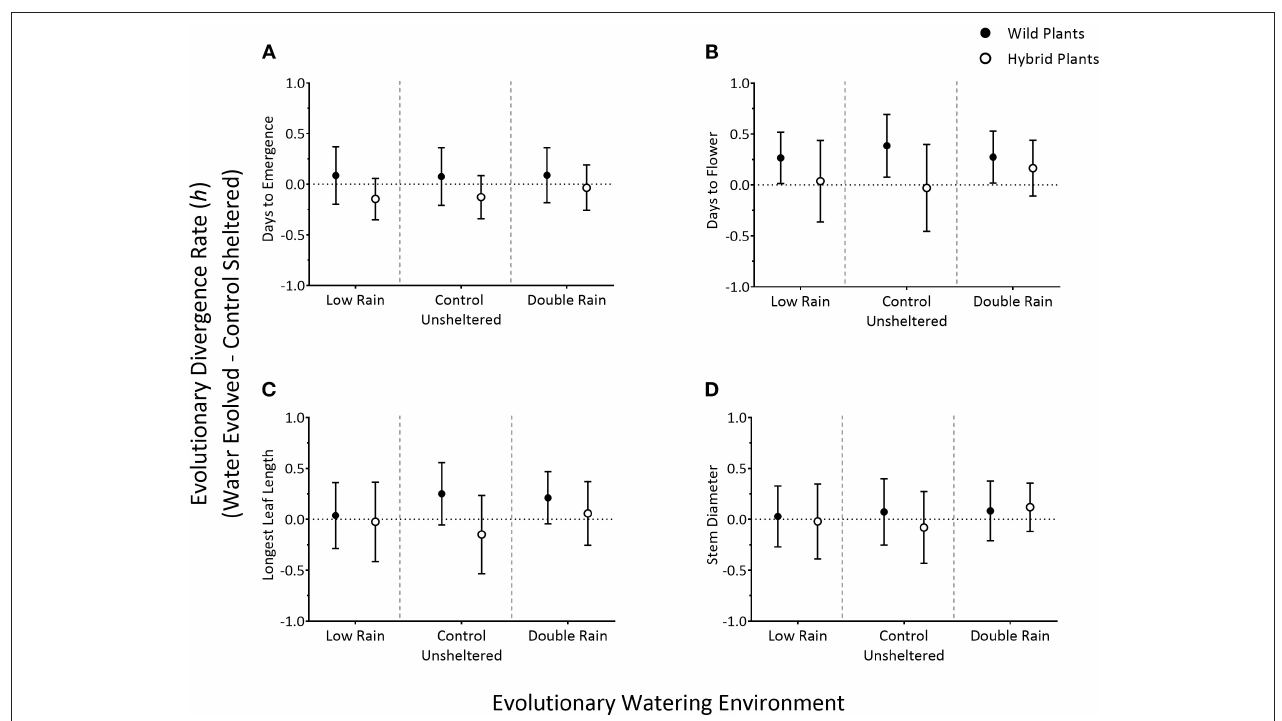
FIGURE 3 | Comparing evolutionary rate estimates [in haldanes ( h ) ± SD ] of four traits—days to seedling emergence (A) , days to flowering (B) , longest leaf length (C) , and stem diameter (D) —of G 5 wild and hybrid radish plants (wild—closed circles, hybrid—open circles) from one of three environmental conditions (low-rain, control-unsheltered, double rain; separated by a gray dashed line) grown in common garden conditions. Values represent change between water-evolved plants and control sheltered plants for each respective treatment (i.e., change between Low Rain-evolved and Control Sheltered, Control Unsheltered-evolved and Control Sheltered, and Double Rain-evolved and Control